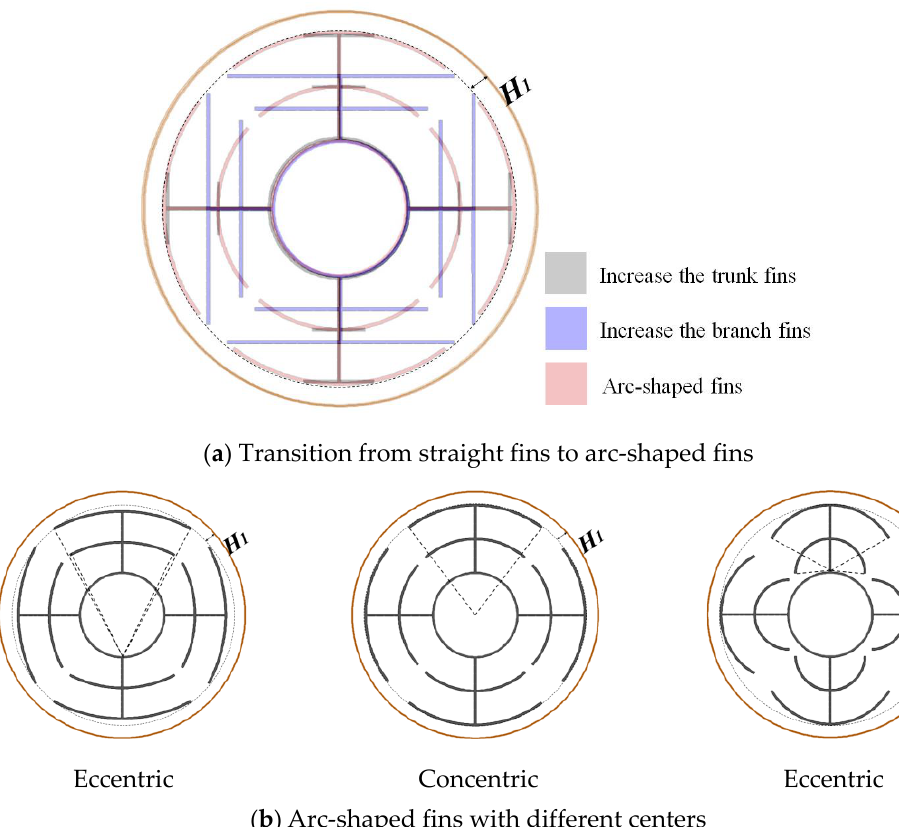
Figure 17. Schematic of arc-shaped fins.